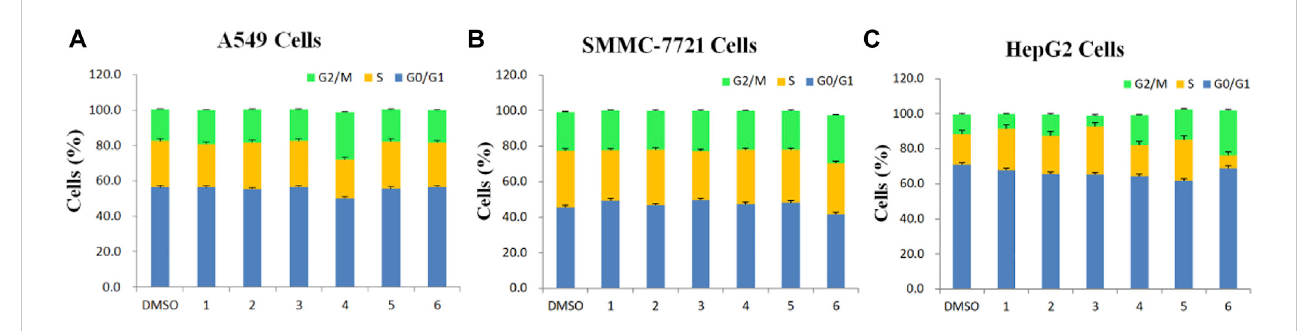
FIGURE 3 Determination of cell cycle stage in three cancer cell lines (A549, SMMC-7721 and HepG2) in the presence of puri fi ed